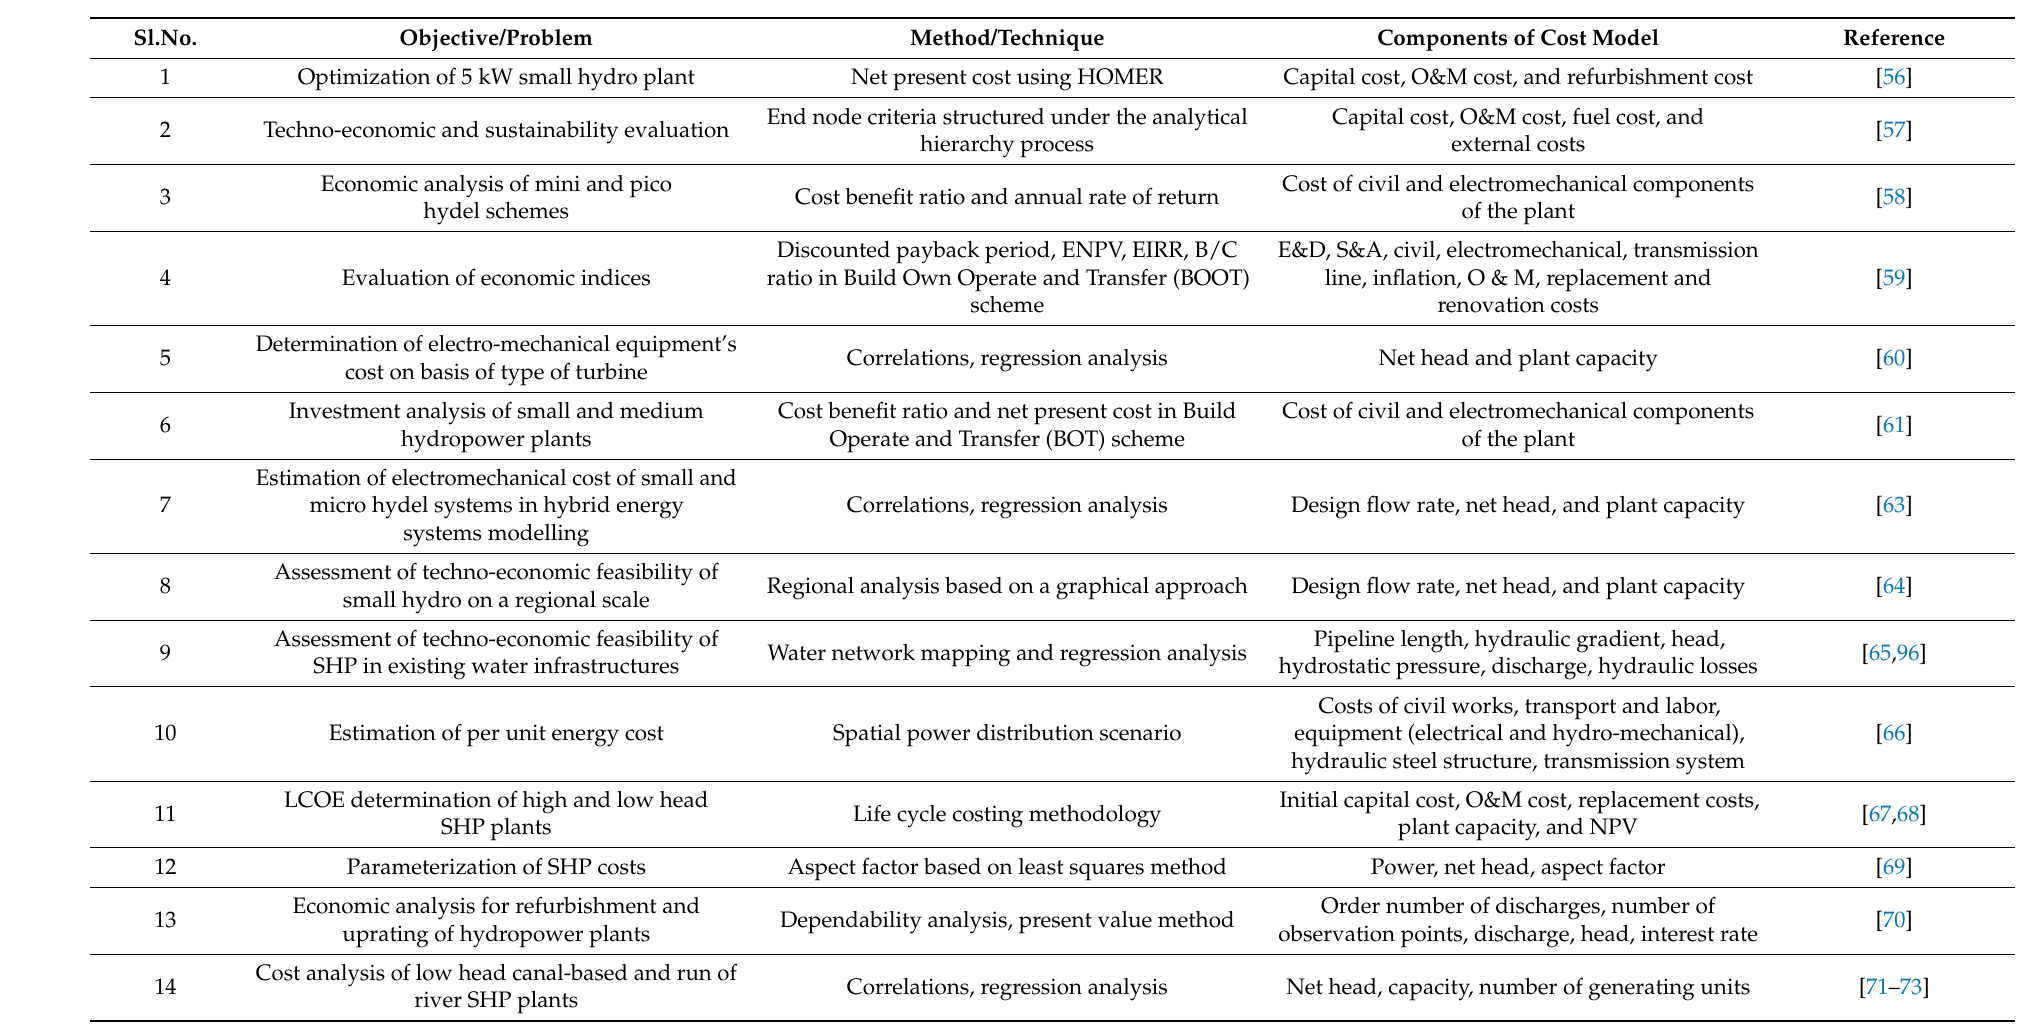
Table 5. Comparison of various economic analysis